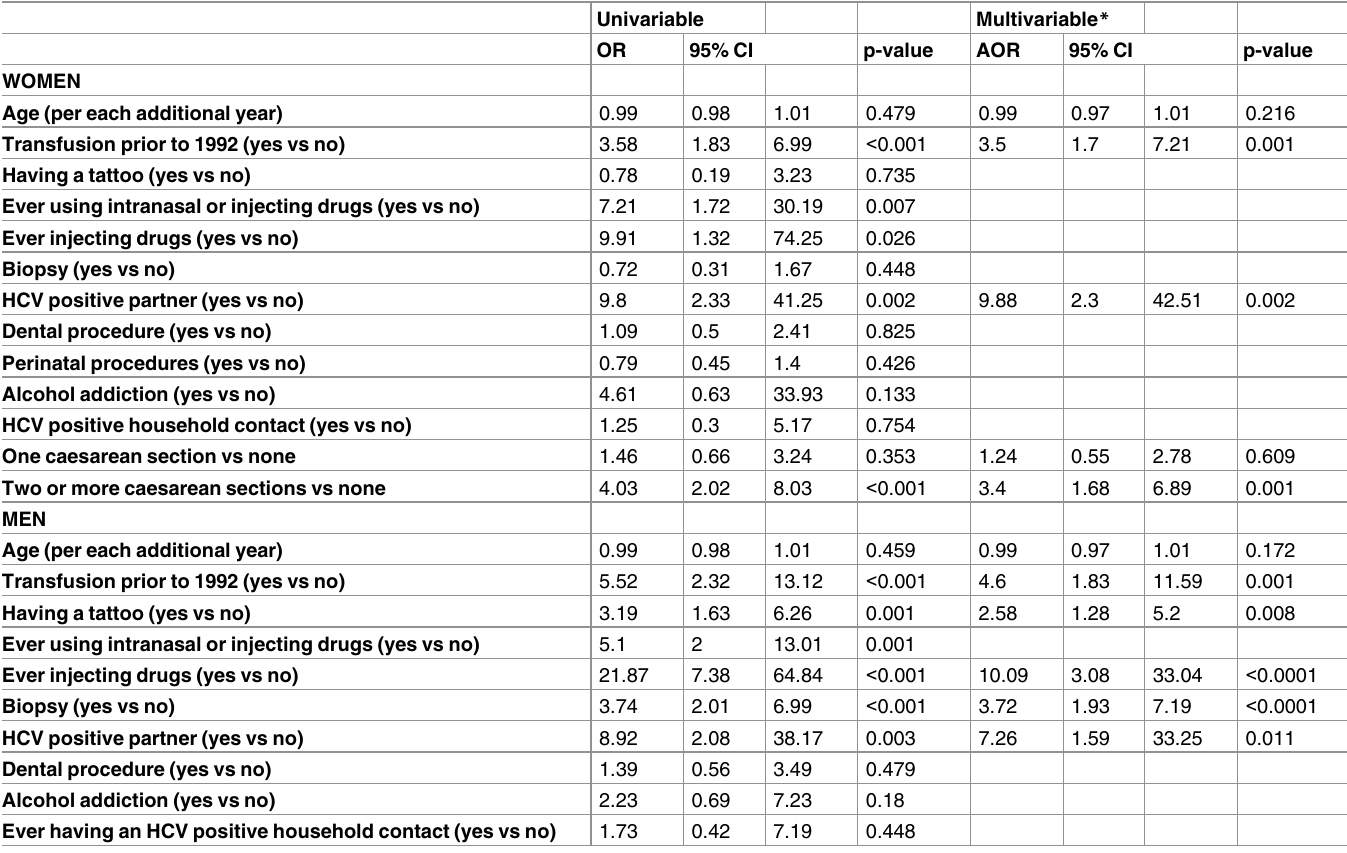
Table 2. Univariate and multivariate associations between predictive factors and HCV infection by